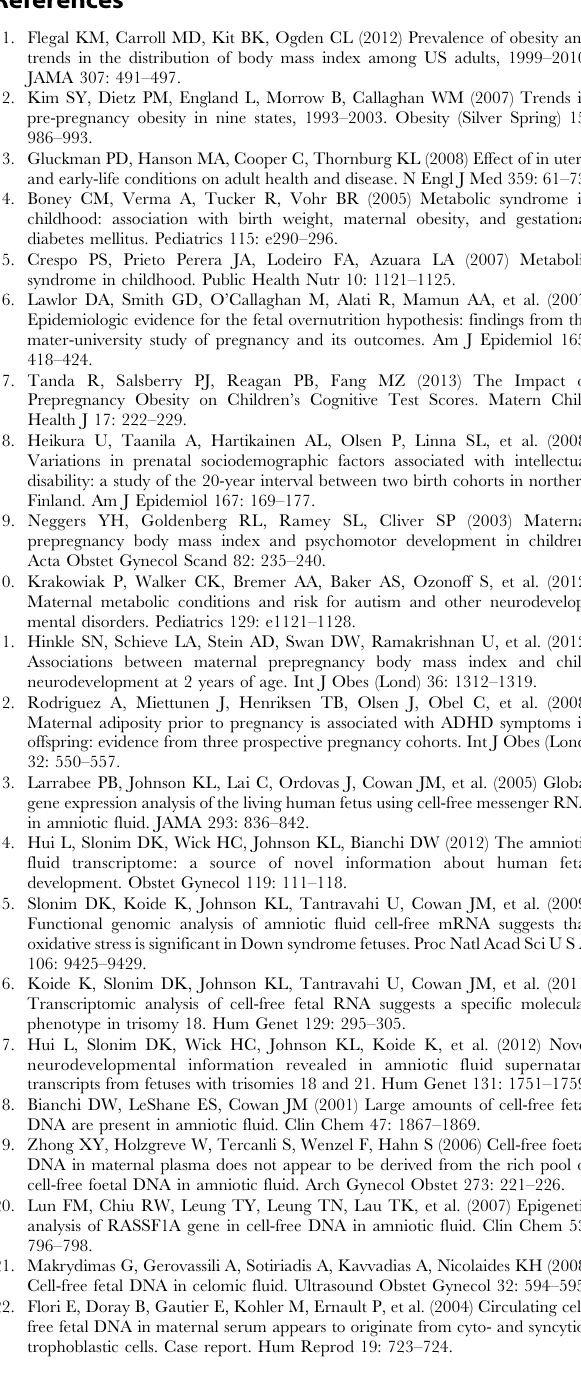
Table S3 Significantly differentially regulated physiological systems in fetuses of obese versus lean women, with associated functional